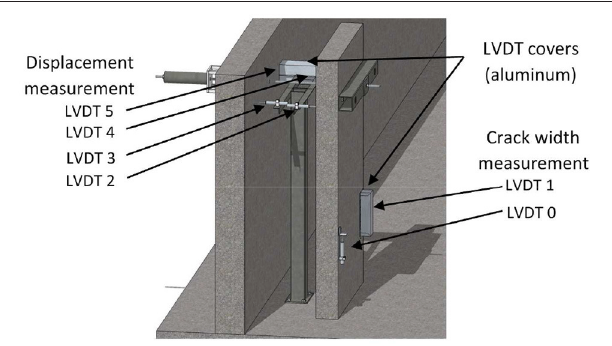
FIGURE 10 | Locations of LVDTs on trial panels.